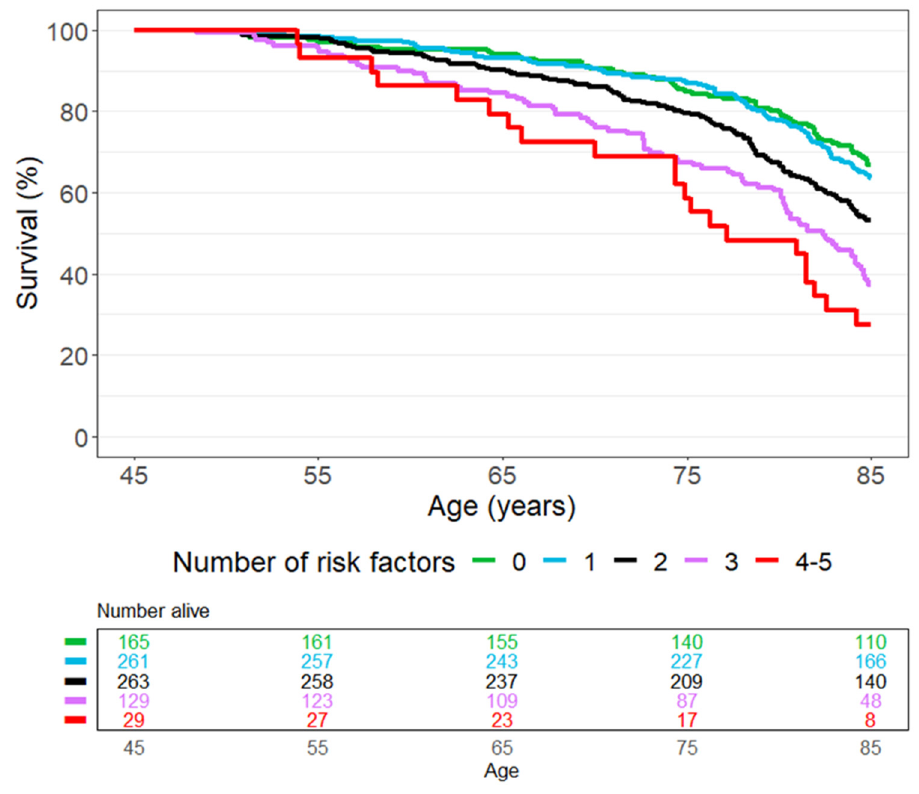
Figure 2. Survival curves for all-cause mortality by number of risk factors recorded at age 45–49 years (Tromsø2). The risk factors are daily smoking, physical inactivity, unmarried, obesity (body mass index ≥ 30 kg/m 2 ), high blood pressure (use of blood pressure medication, systolic blood pressure ≥ 140 mmHg, or diastolic pressure ≥ 90 mmHg), and high cholesterol (total cholesterol > 7 mmol/L). The Tromsø Study 1979–2019.